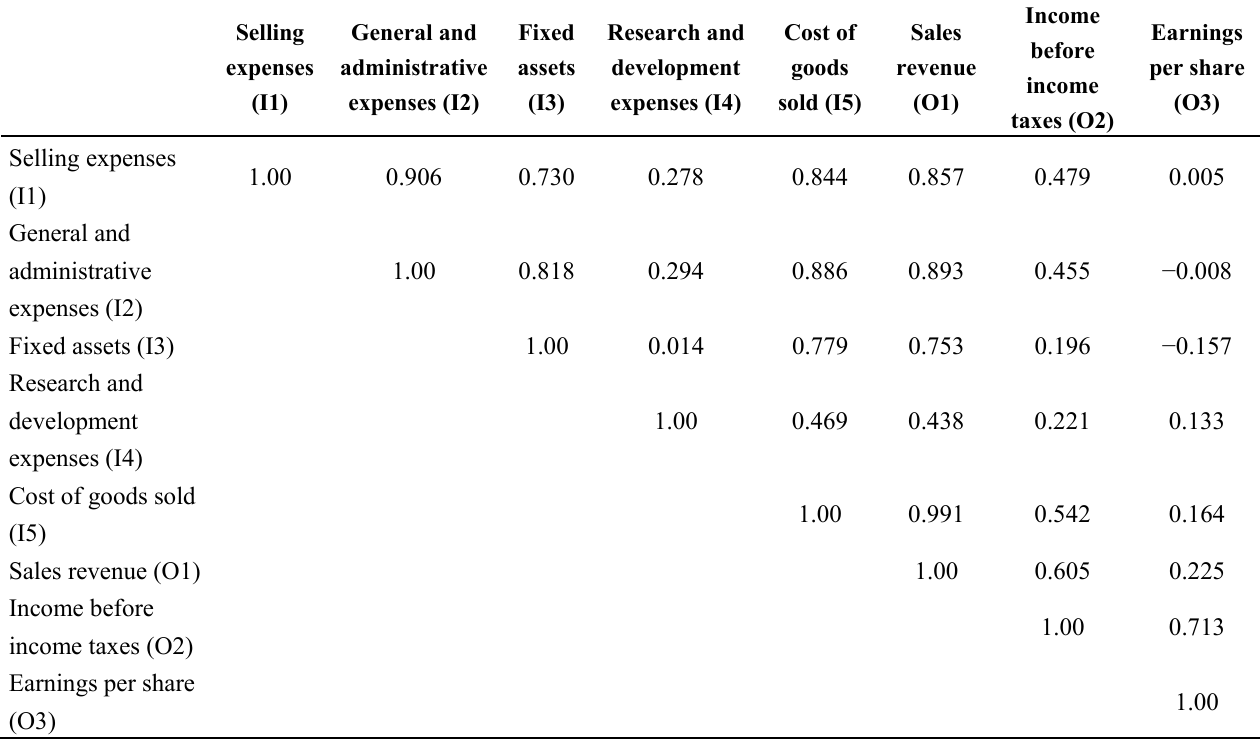
Table 5. Correlation analysis of the factors.